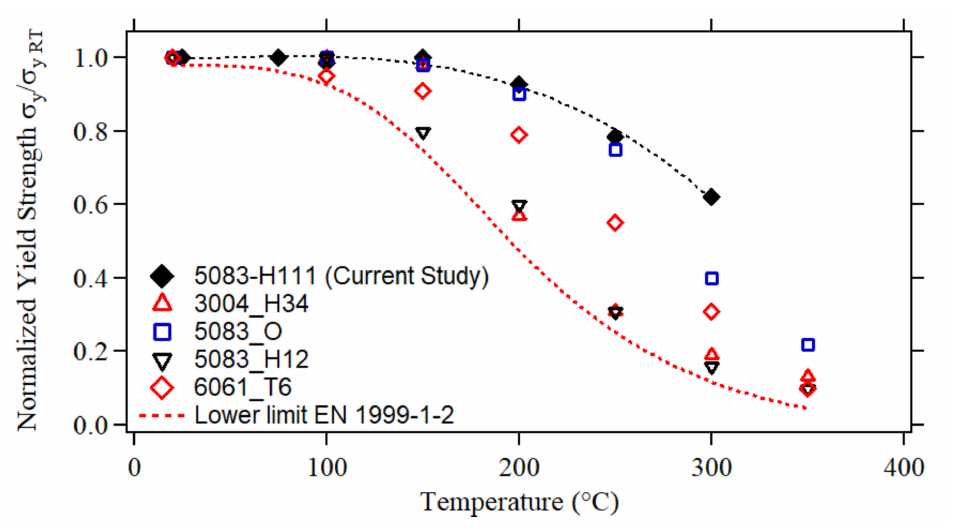
Figure 8. Normalized yield strength versus temperature (normalized by the RT yield